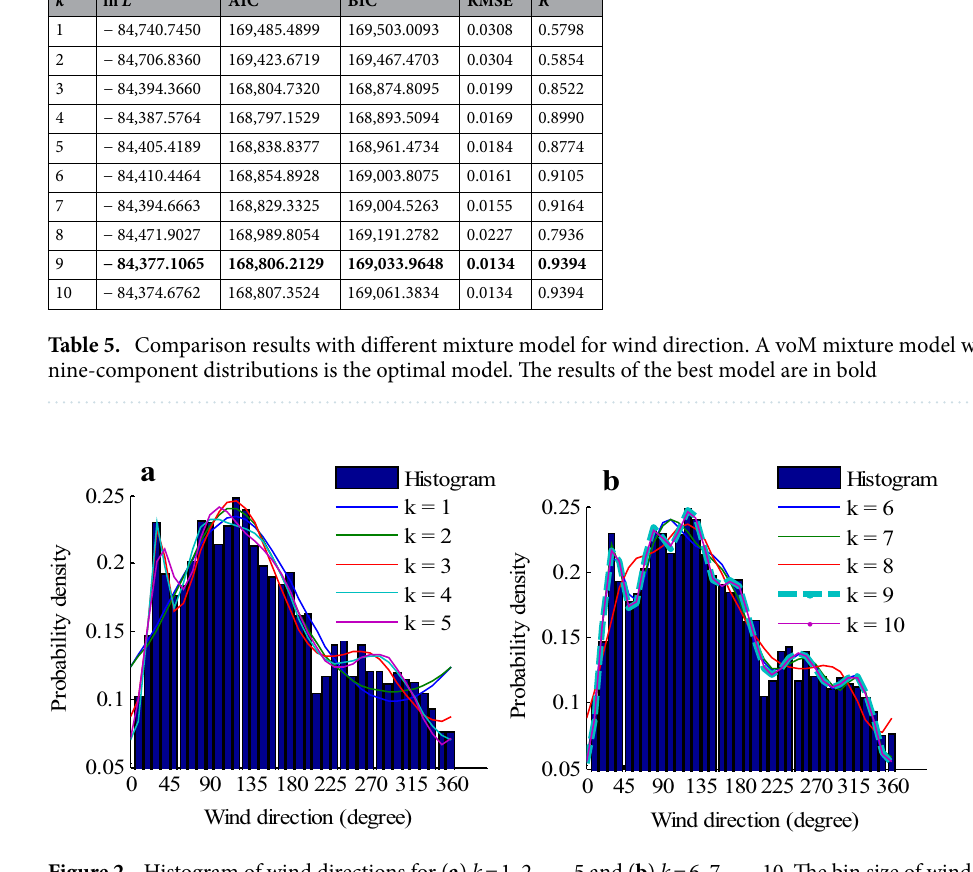
Figure 2. Histogram of wind directions for ( a ) k = 1, 2, …, 5 and ( b ) k = 6, 7, …, 10. The bin size of wind direction interval is 10°. A voM mixture model with nine-component distributions ( b green bold dash line) fits the histogram of wind direction well in all candidate model with different components. Figure created using Matlab R2014a (https:// www. mathw orks.